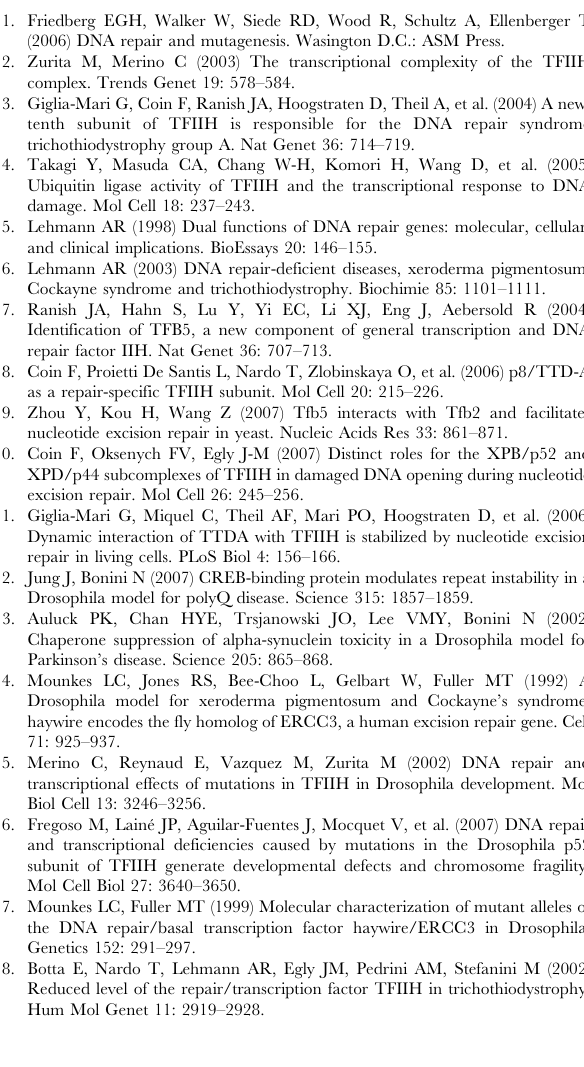
were irradiated and then allowed to develop to adults. Survival rate is indicated for each strain. The graph represents the results of at least three independent dose-response experiments for each genotype. The statistical analysis by ANOVA indicates a P value , 0.001 for the parental strain ( red , e/red , e ) compared with the rescued homozygous ( mrn 3 /mrn 3 ) and the heterozygous ( mrn 3 / + ) strains at 150 J/m 2 . The different genotypes are indicated in the